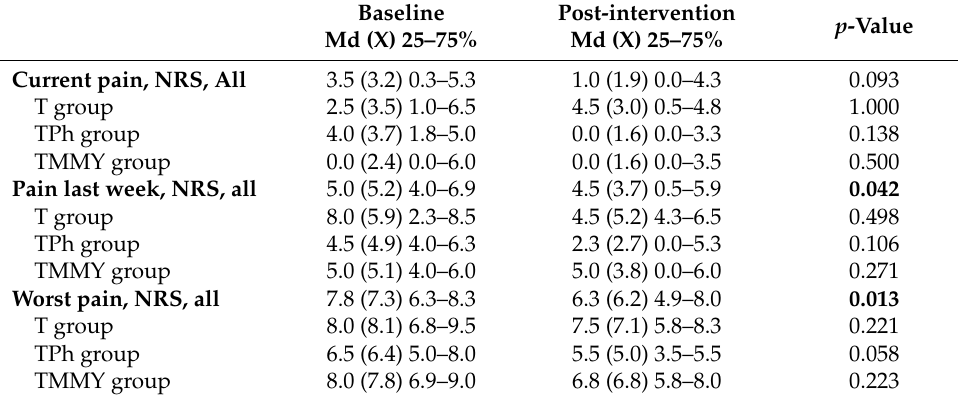
Table 1. Pain assessed by a numeric rating scale (NRS) at baseline and post-intervention.